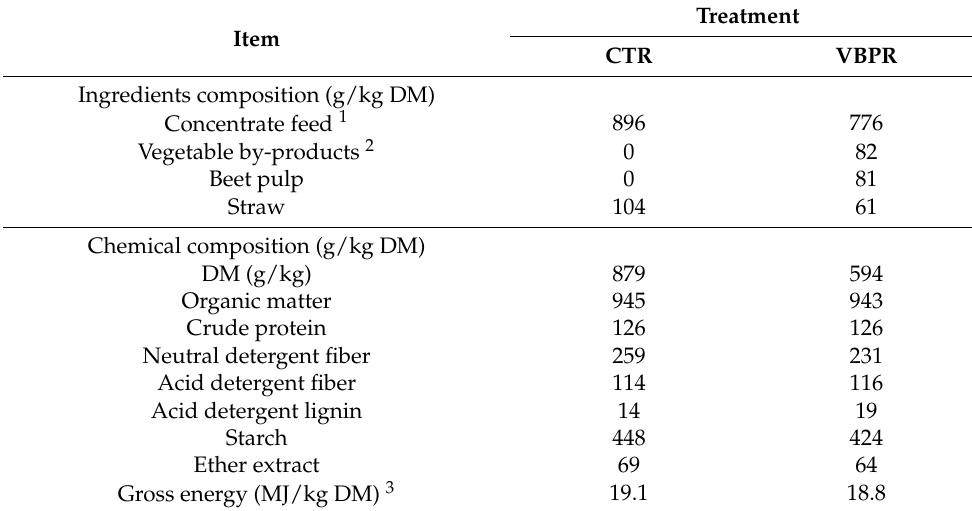
Table 2. Ingredients and chemical composition of the experimental